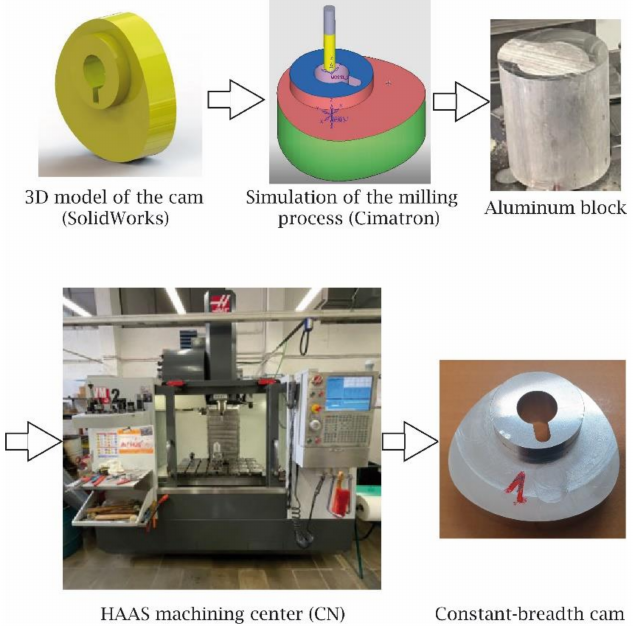
Figure 12. The sequence of steps followed to manufacture the metallic cams.